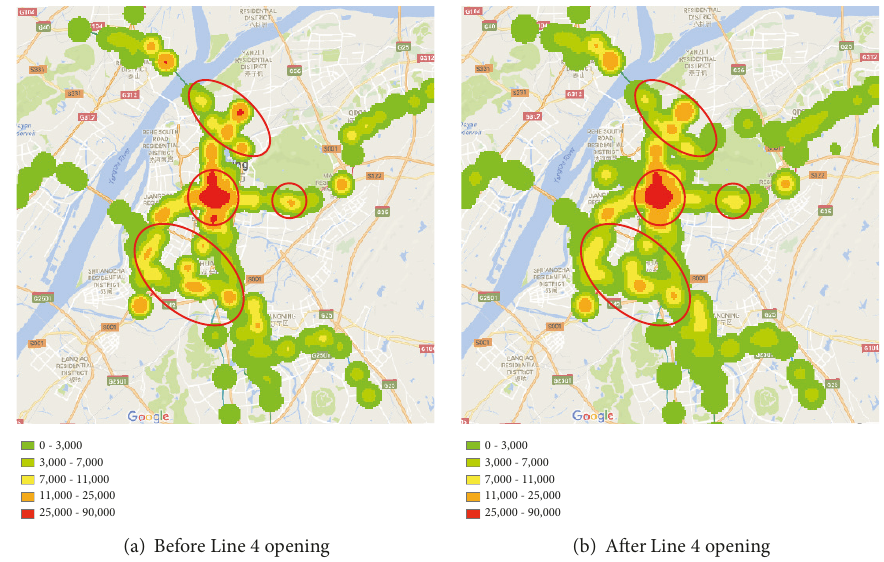
Figure 4: Spatial distribution of metro passenger flow before and after Line 4 opening (map source: Google Maps).